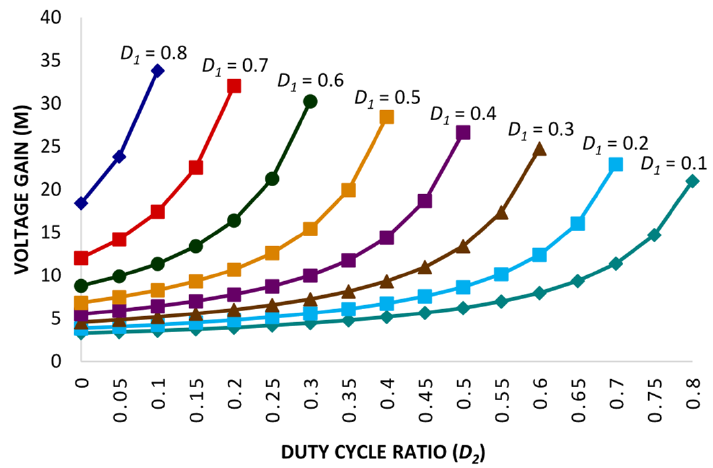
Figure 6. Voltage gain response under varying duty ratios D 1 and D 2 for the proposed converter.